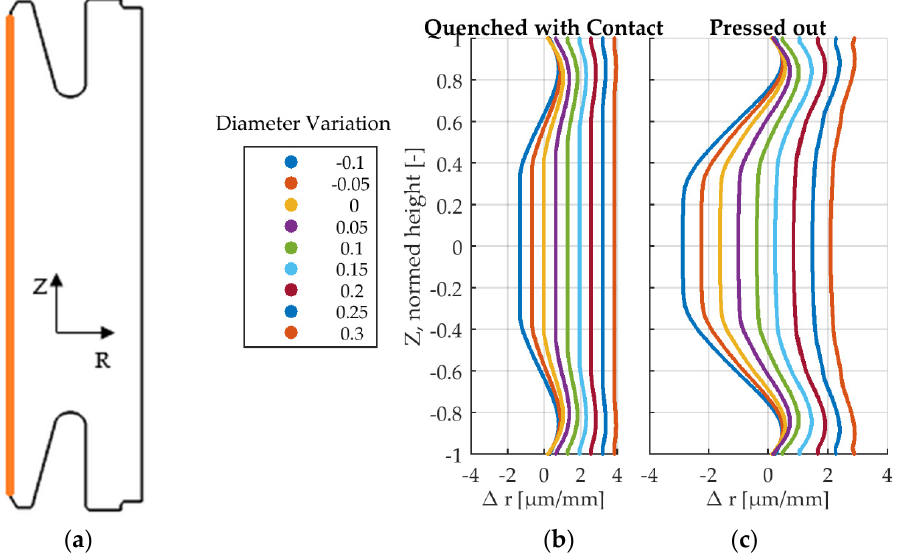
Figure 13. Relative displacement in µm/mm. ( a ) Measurement location. ( b ) Quenched, in contact with mandrel; ( c ) Pressed out, no contact, release of elastic energy. The area of the part that has been in contact shows a larger displacement after mandrel removal.